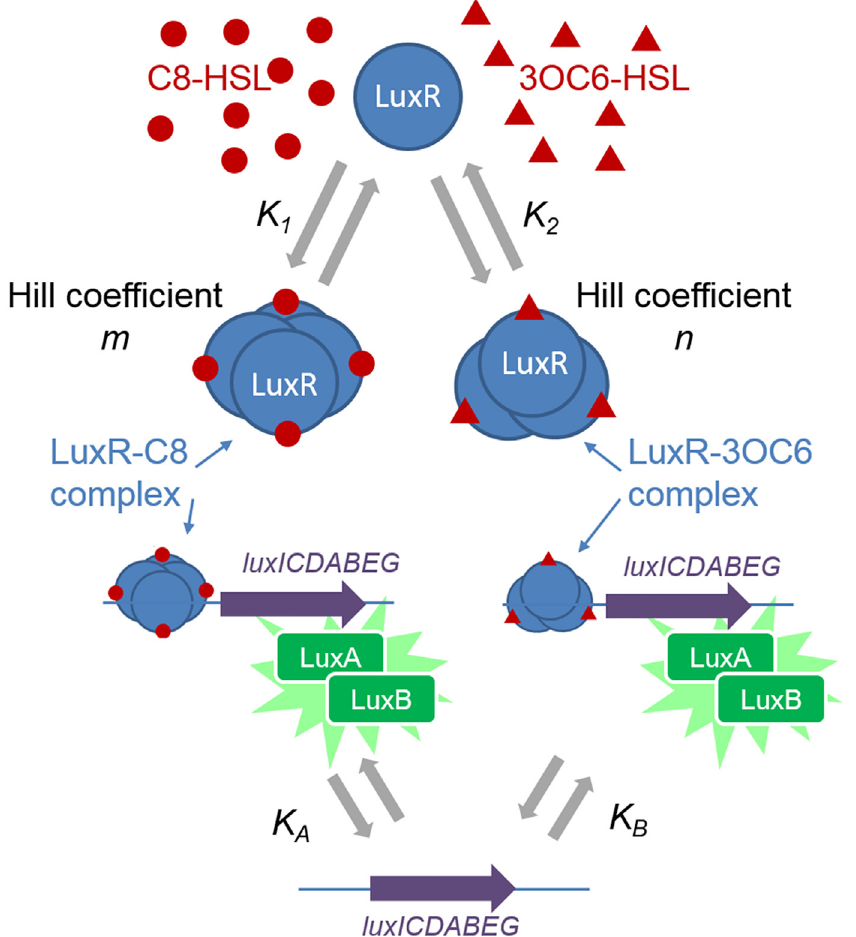
Fig 1. Model for LuxR-mediated induction of V . fischeri luminescence by C8-HSL and 3OC6-HSL. The pheromones C8-HSL and 3OC6-HSL interact with LuxR to form complexes with dissociation constants K 1 and K 2 (and Hill coefficients m and n ) respectively. These complexes bind to the lux box (dissociation constants K A and K B respectively) to activate expression of the lux operon and synthesis of LuxA and LuxB, the subunits of the bacterial luciferase. The luminescence is proportional to the concentration of the LuxA-LuxB heterodimer